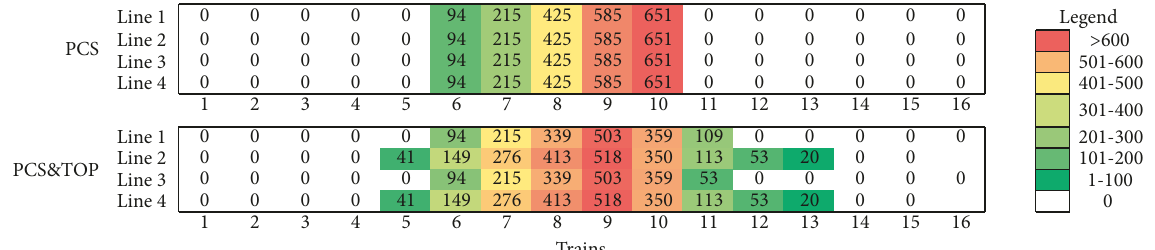
Figure 8: The entrance waiting time of passengers in different